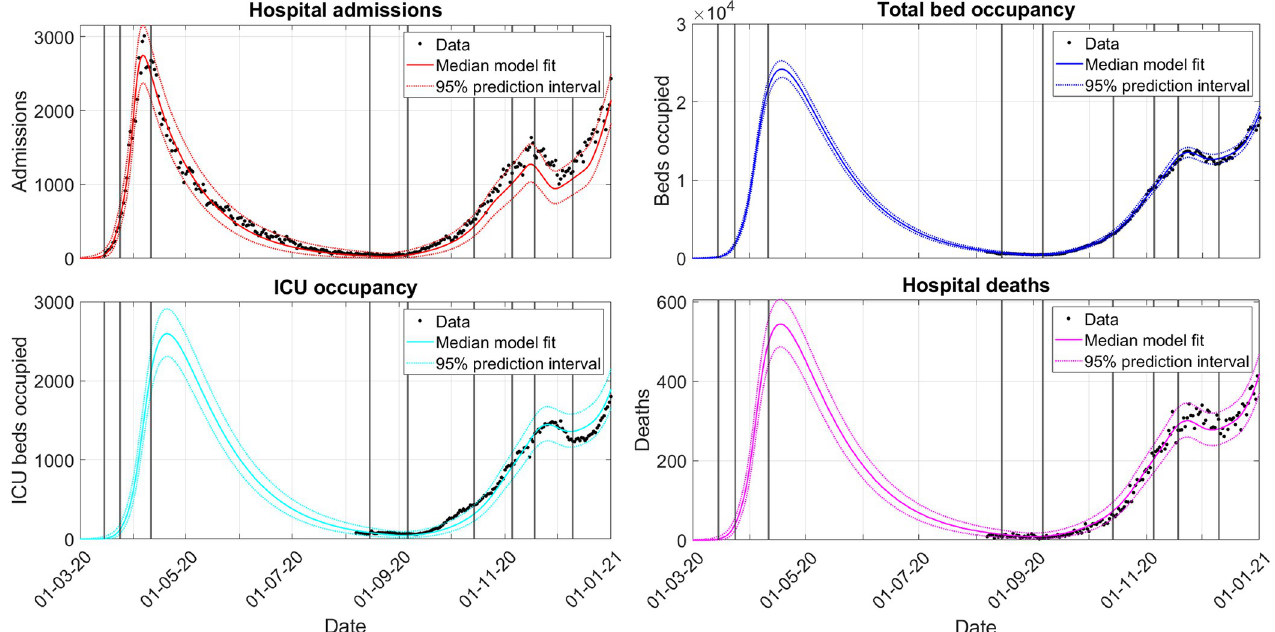
Fig 3. Second-wave model fit to admissions (red), beds (blue), ICU beds (cyan) and deaths (magenta). Admissions data were fitted starting from 1 st March 2020, while the other three data streams were fitted starting from 1 st August 2020. Vertical lines indicate when transmission rate changes are added to EpiBeds (see Section SM.1.3.3 in S1 Supplementary Material). Note that there is a delay between transmission changing in the community and its effect being observed in the hospital data, so visual inflections in the model trend occur after the transmission change point. The 90% prediction interval was calculated by generating, for each parameter posterior sample, a new potential realisation of the data and then taking the 5 and 95 quantiles of the set of realised data at each time point. All dates are given as day/month/year.